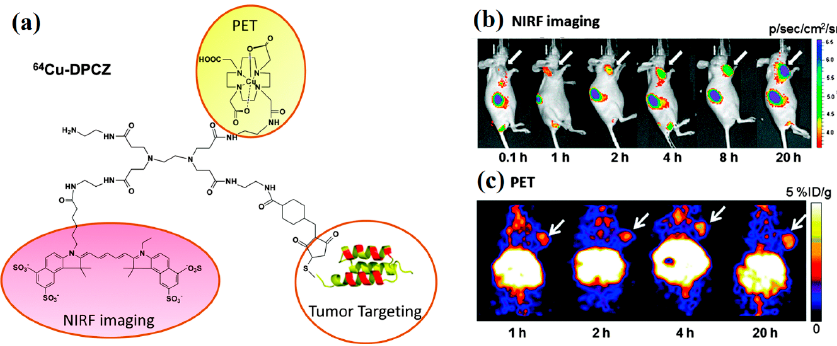
Figure 6. ( a ) Schematic structure of 64 Cu-DPCZ which is constituted by four components, PAMAM G0 as a scaffold, Cy5.5 as an optical reporter, 64 Cu-DOTA as a PET reporter and Affibody as a tumor targeting molecule; ( b ) In vivo NIRF imaging of SKOV3 tumor-bearing mice at 0.1, 1, 2, 4, 8, and 20 h after tail vein injection of 64 Cu-DPCZ; ( c ) Decay-corrected coronal micro-PET images of mice bearing SKOV3 tumor at 1, 2, 4 and 20 h after tail vein injection of 64 Cu-DPCZ. Arrows indicate the location of the tumors ( n = 3) (adapted from [97], Chemical Communications, 2014).